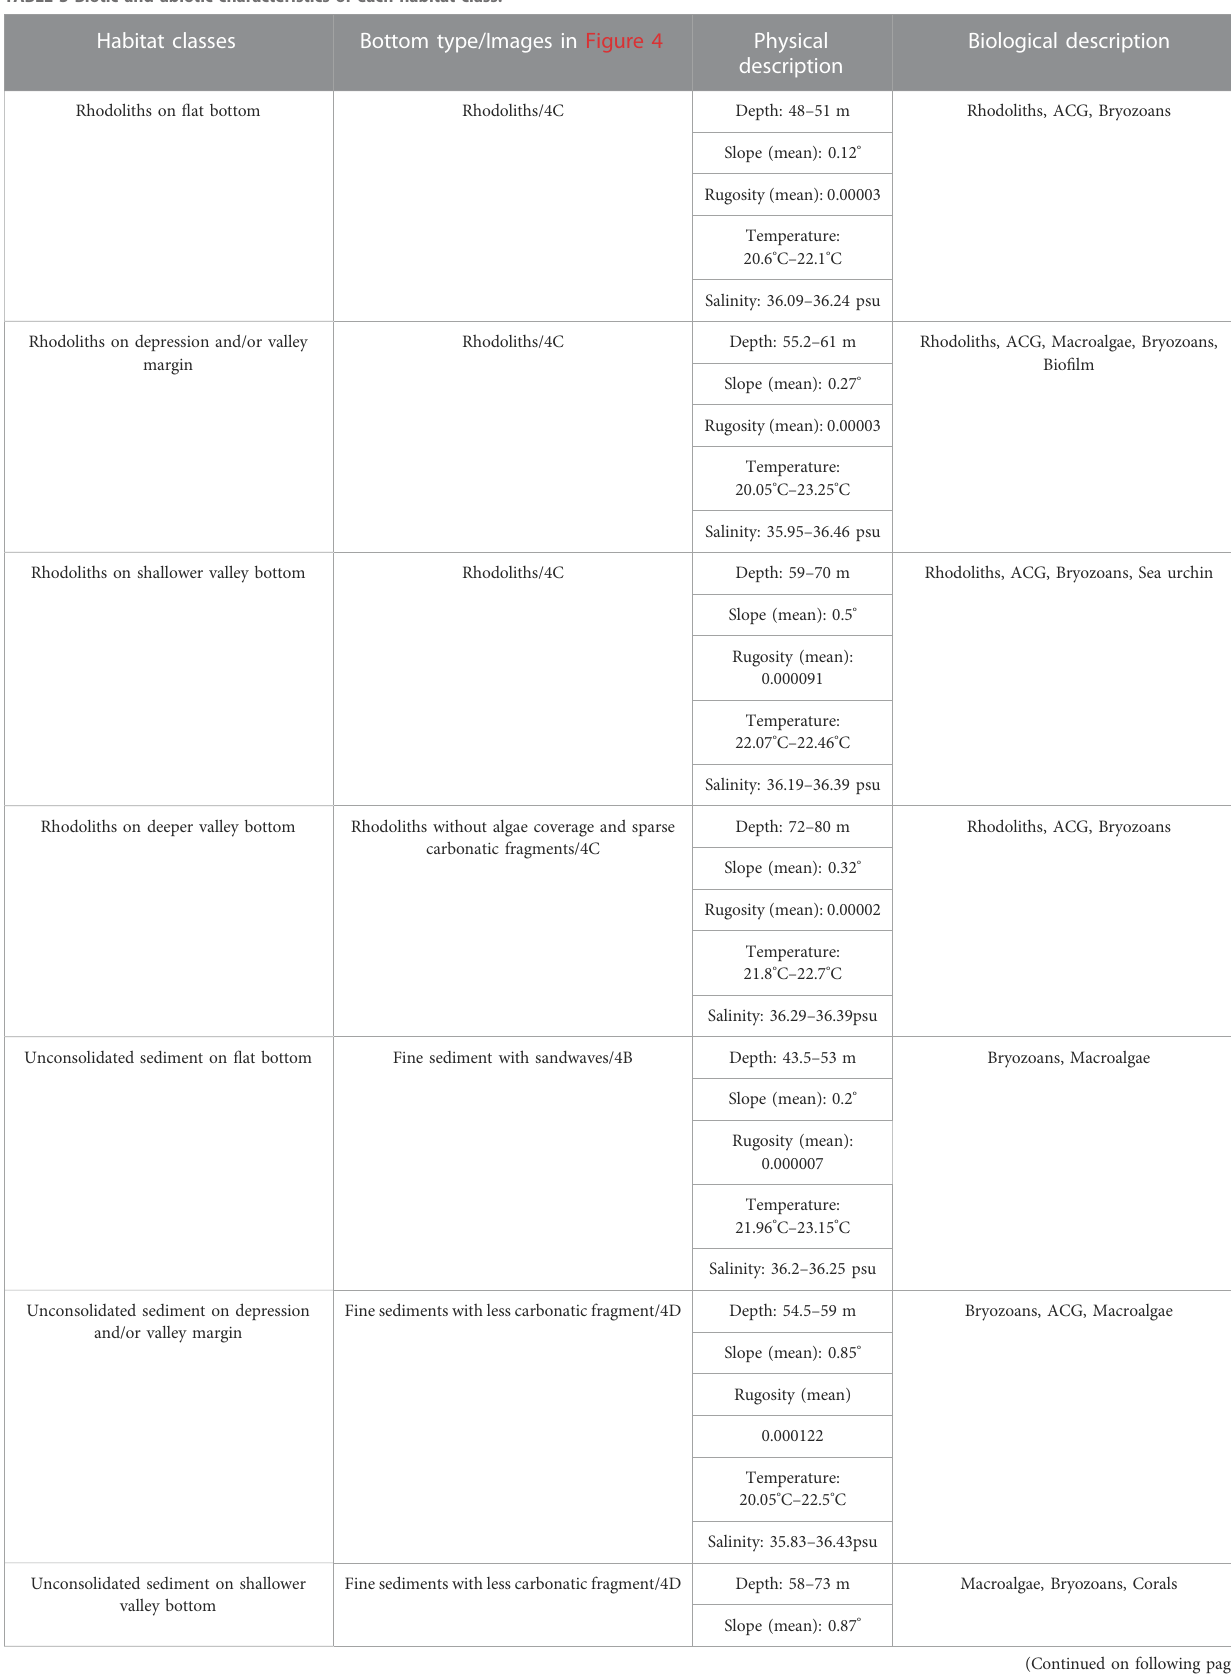
TABLE 3 Biotic and abiotic characteristics of each habitat